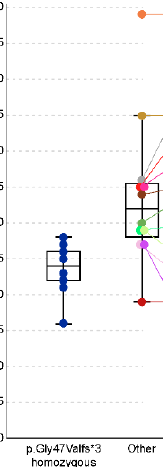
Figure 7. ( A ) The correlations between age and lesion area on fundus autofluorescence imaging. All patients with longitudinal imaging showed increases in lesion area with time. Note the relatively small lesion area size of Patient 2, harboring p.Met1? and p.Leu246Pro. ( B ) The correlations between lesion area and visual acuity on fundus autofluorescence imaging. Note the relatively large lesion area size and good visual acuity of Patient 21 at the age of 37 years. Visual acuity in this patient deteriorated to 1.3 LogMAR after 10 years, but his OCT images for evaluating the integrity of his photoreceptor layer are not available. On the other hand, Patient 4 had relatively small lesion area size and poor visual acuity (1.5 LogMAR). On OCT, the integrity of external limiting membrane was still preserved in this patient. Note that the colors of the patients are the same in Figures 5–8. 0 20.00040.00060.000 80.000